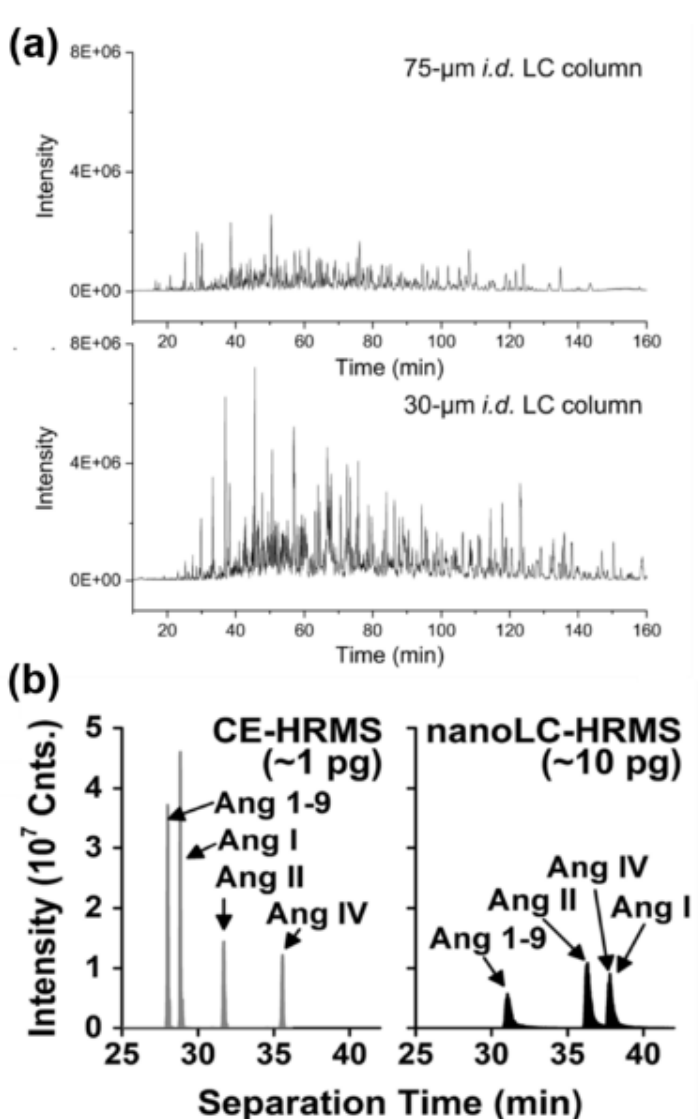
Figure 5. Advanced separation modalities for the sensitive analysis of peptides and protein from low-sample input. ( a ) Reduction of the capillary diameter for reversed-phase chromatography enhances the peptide signal in shot-gun proteomic analysis. Figure adapted with permission from reference [87]. ( b ) Capillary electrophoresis (CE) enables ultra-sensitive analysis of peptides. Adapted with permission from reference